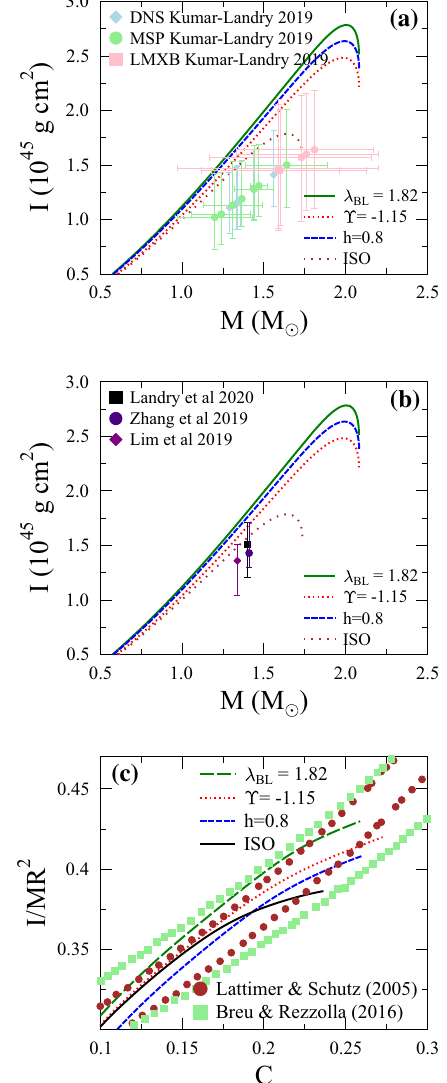
Fig. 8 Impact of anisotropic pressure on inertia moment of NS with hyperons ( a , b ). For comparison, we also include in b , new non- parametric constraint on inertia moment of canonical NS from Ref. [9], and the one from joint PSR J0030+0451, GW170817, the nuclear data analysis constraints from Ref. [30]. The predicting the moment inertia of pulsar J0737 − 3039A from Bayesian modeling of nuclear EOS of Ref. [21] also is given. While in a , we include the inferring moment inertia of DNS, MSP, and LMXB obtained from GW178087 with uni- versal relations [22]. For dimensionless inertia moment as a function of compactness case ( c ), we include the results of Refs. [18,20] for